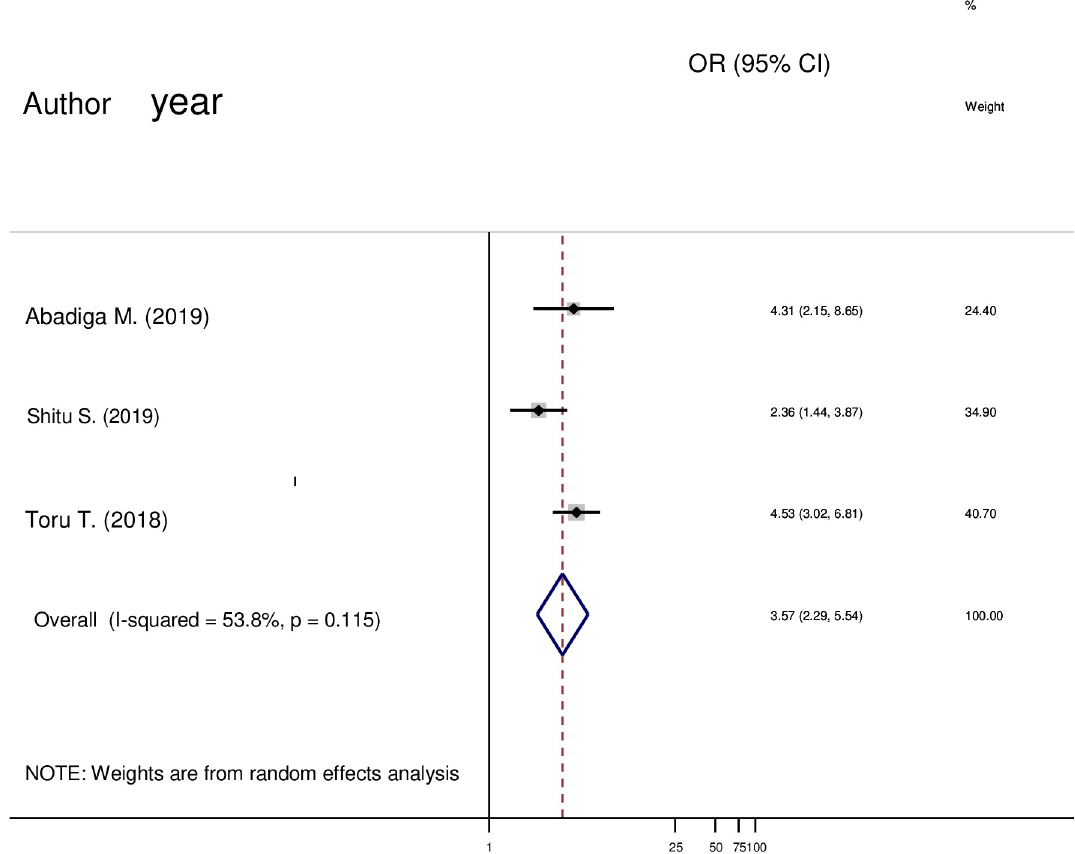
Fig 7. Forest plot pooled random effect size (OR) of poor social support related to strong social support in post-partum depression among mothers in Ethiopia,